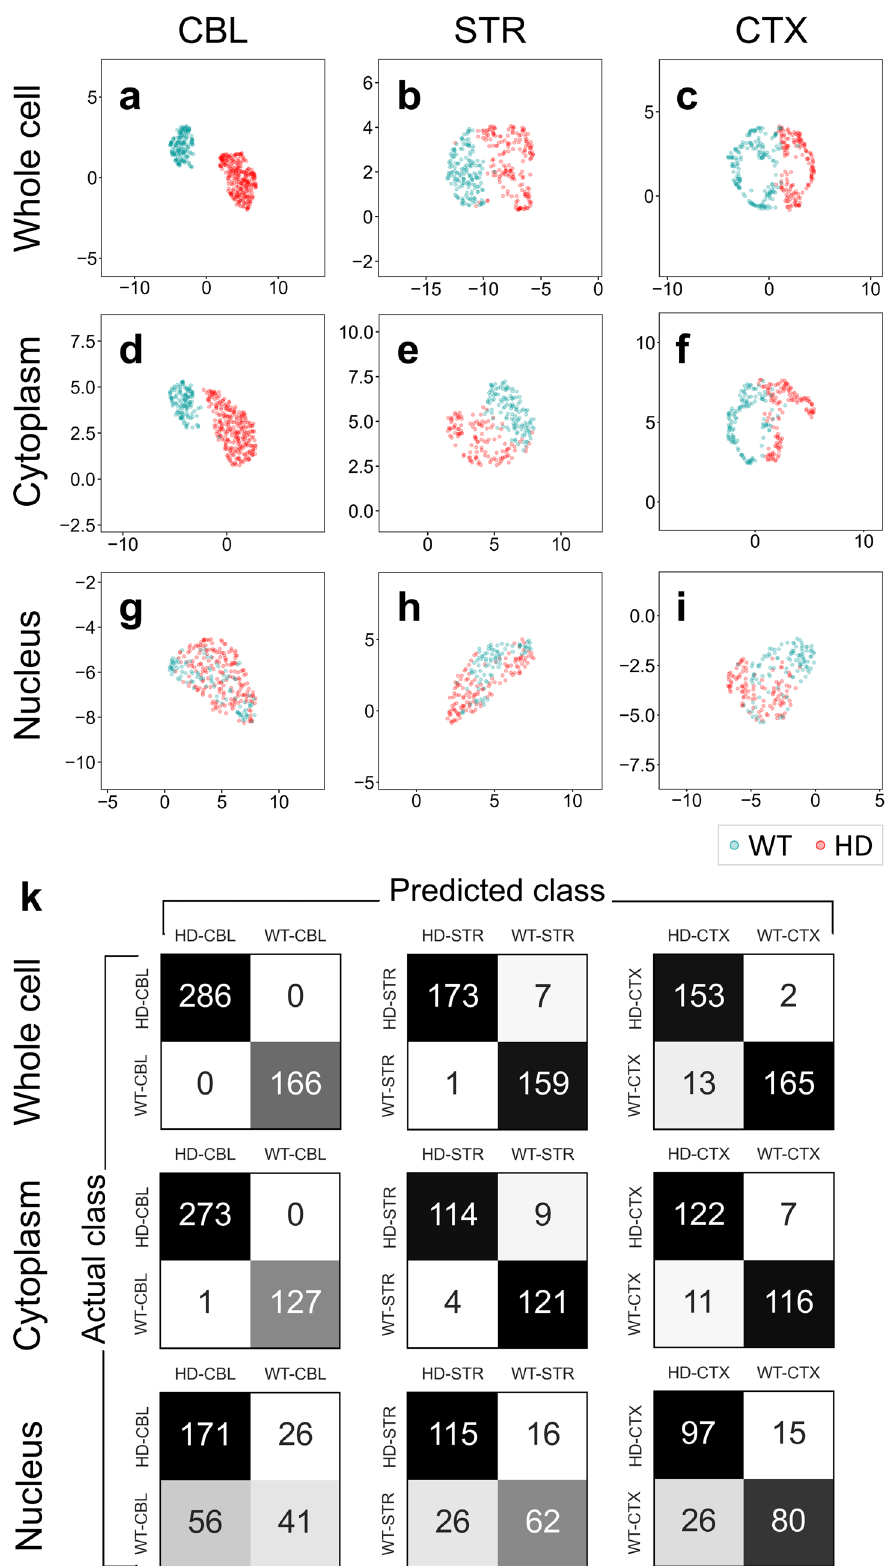
Figure 5. Spectral phenotyping accurately predicts disease class in HD astrocytes. UMAP clustering and classification derived from segmented whole cell ( a – c ), cytoplasm ( d – f ) or nucleus ( g – i ) for three regions of the brain CBL ( a , d , g ), STR ( b , e , h ) and CTX ( c , f , i ). ( k ) Confusion matrices corresponding to each UMAP ( a – i ). The predicted and actual classification results for HD and WT astrocytes in the whole cell, cytoplasm, and nucleus for all three brain regions are listed in Table